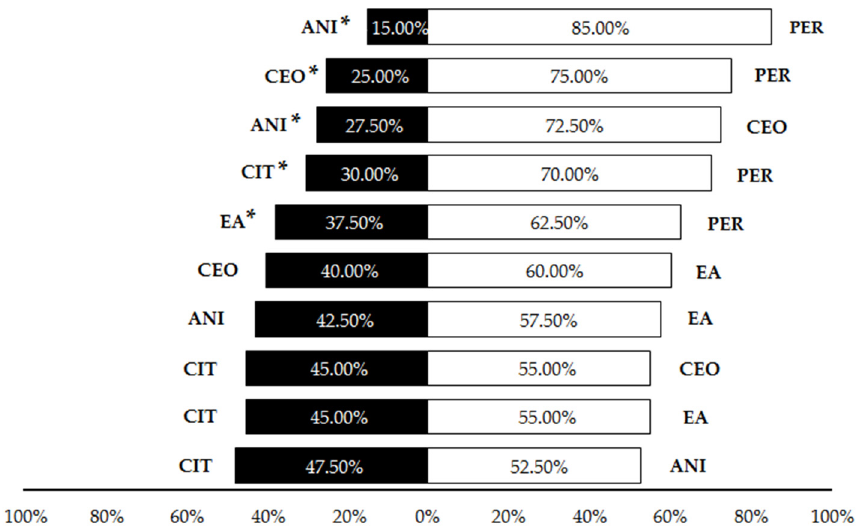
Figure 5. Percentage of Pheidole pallidula workers responding to each odor source in different paired combinations of compounds in the olfactory tests. Asterisks (*) indicate significant differences between compounds in each choice ( p ≤ 0.05). CEO: cinnamon essential oil; CIT: citronella essential oil; ANI: p-anisaldehyde; EA: ethyl anthranilate; PER: permethrin. When repellents were incorporated into LDPE plastic, comparisons with controls showed that cinnamon oil was significantly repellent (67.5% of choices for controls), un- like p-anisaldehyde (60%), ethyl anthranilate and citronella essential oil (57.5%) (Table 1, Figure 6A). When incorporated into HDPE at 3%, p-anisaldehyde, cinnamon essential oil and citronella essential oil were also repellent, leading to a proportion of 80, 67.5 and 62.5% of choices for controls, respectively. Ethyl anthranilate showed no repellence (50% of responses for each source) under these circumstances (Table 1, Figure 6B). Finally, the trials with HDPE samples at 5% concentration revealed significant repellence for all tested compounds (CEO: 72.5% of choices for controls; EA and ANI: 67.5%; CIT: 65%) (Table 1, Figure 6C). These results suggest a certain positive effect of both plastic density and com- pound concentration on the repellent effect of